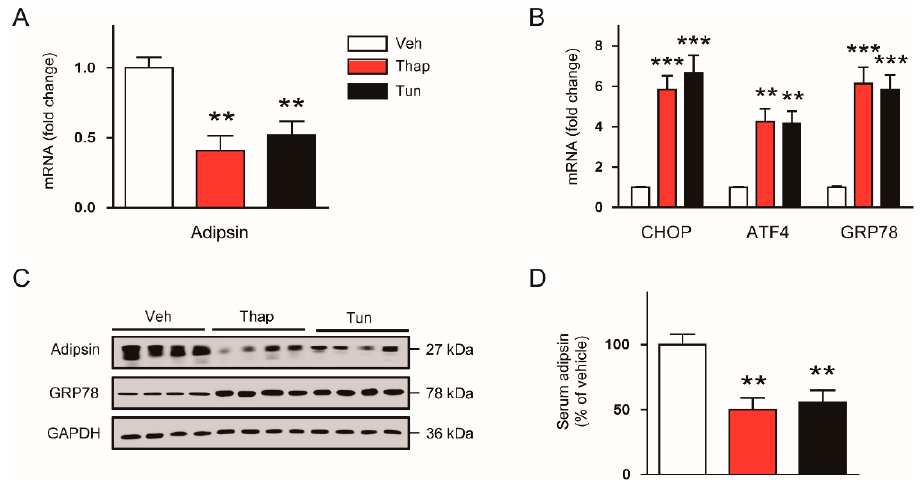
Figure 2. Acute ER stress downregulates adipsin expression in vivo. C57BL / 6N mice were intraperitoneally injected with vehicle (Veh; dimethyl sulfoxide), thapsigargin (Thap; 1 mg / kg), or tunicamycin (Tun; 2.5 mg / kg). After 6 h, the mice were sacrificed. ( A ) Real-time RT-PCR analysis of adipsin in gWATs. ( B ) Real-time RT-PCR analysis of CHOP, ATF4, and GRP78 in gWATs. ( C ) Western blot analysis of adipsin, GRP78, and GAPDH in gWATs. GAPDH was used as a loading control. Each lane represents an individual animal. ( D ) Serum levels of circulating adipsin. n = 8 per group. All data are represented as the mean ± SEM. ** p < 0.01, and *** p < 0.001 vs. Veh-treated group.